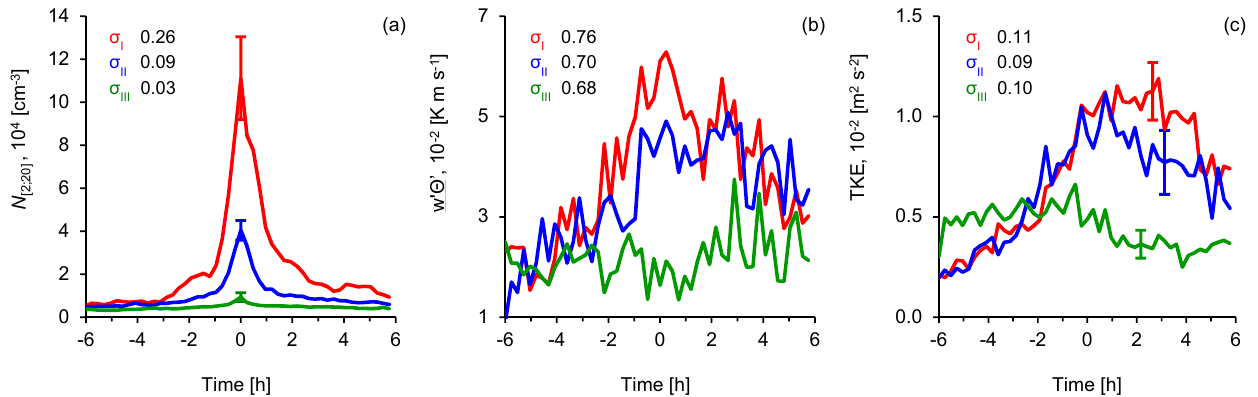
Figure 7. Average time series of (a) the concentrations of ultrafine particles ( N [2;20] ), (b) the vertical turbulent heat flux ( w (cid:48) θ (cid:48) ), and (c) tur- ), (b) the vertical turbulent heat flux (w’  ’) Fig. 5. Time series of (a) the concentrations of ultrafine particles (N bulent kinetic energy (TKE) for the year 2010 and three event classes (red indicates a Class I event, blue indicates a Class II event, and green 2-20 indicates Class III including weak events and “non-events”). Whiskers indicate 1 SD. Data coverage: Class I (19 days), Class II (17 days), and (c) turbulent kinetic energy (TKE) for the year 2010 and 3 Event Classes. (red = Class I event, blue = Class II Class III (27 event, green = Class III including weak events and “non-events”). Whiskers indicate one standard deviation. Data coverage: Class I (19 days), Class II (17 days), Class III (27 days).